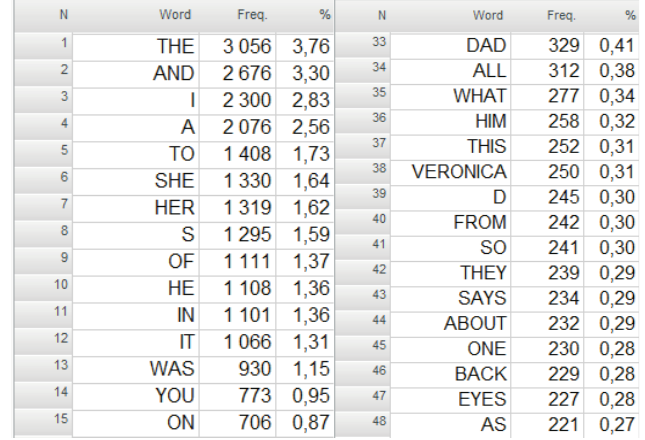
Figure 1. Sections of the wordlist created from the corpus built from the full text of “Vegetarian Tigers of